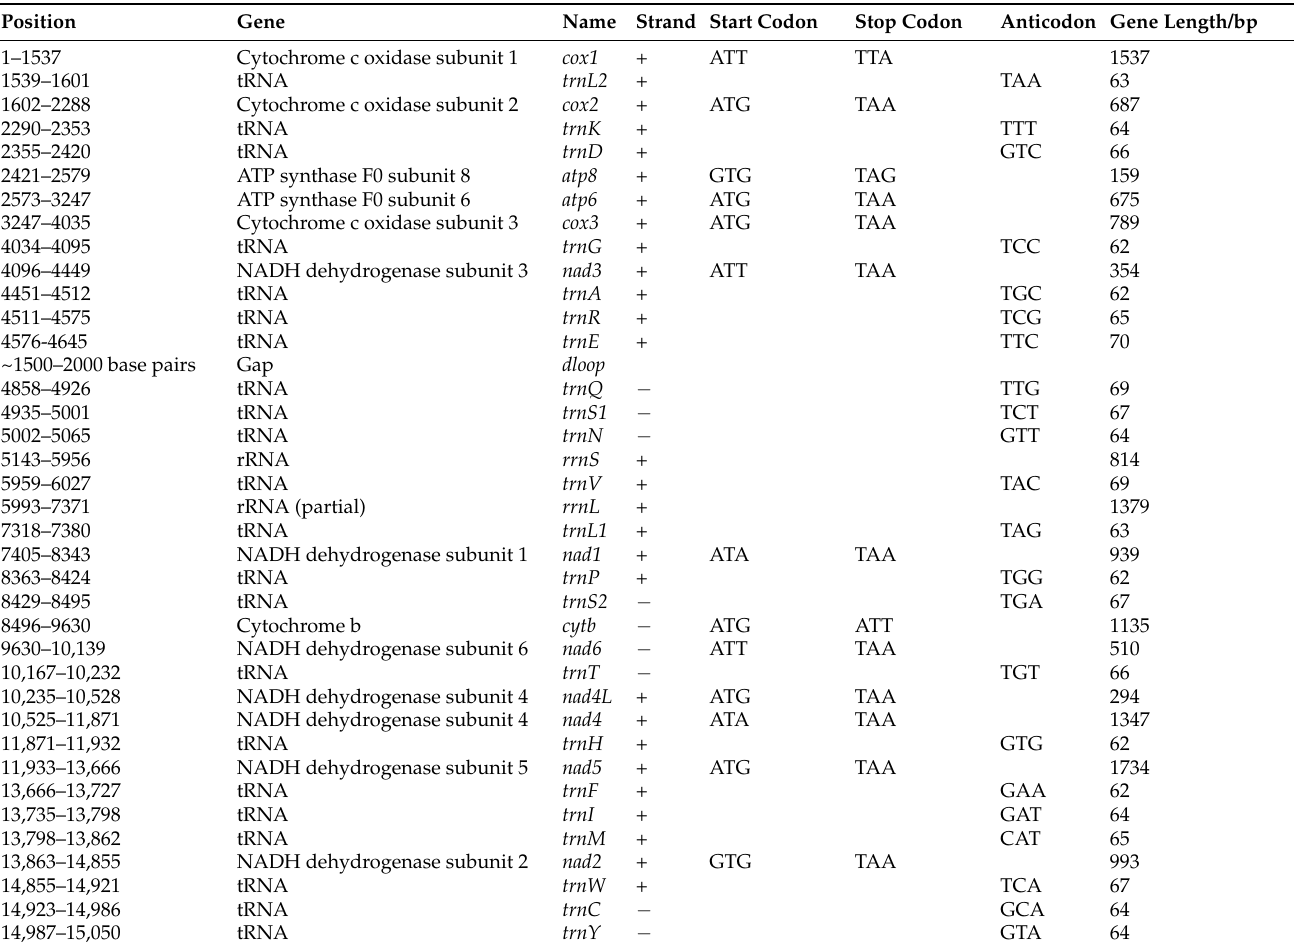
Table 2. Annotation of the coding mitogenome of Pontastacus leptodactylus